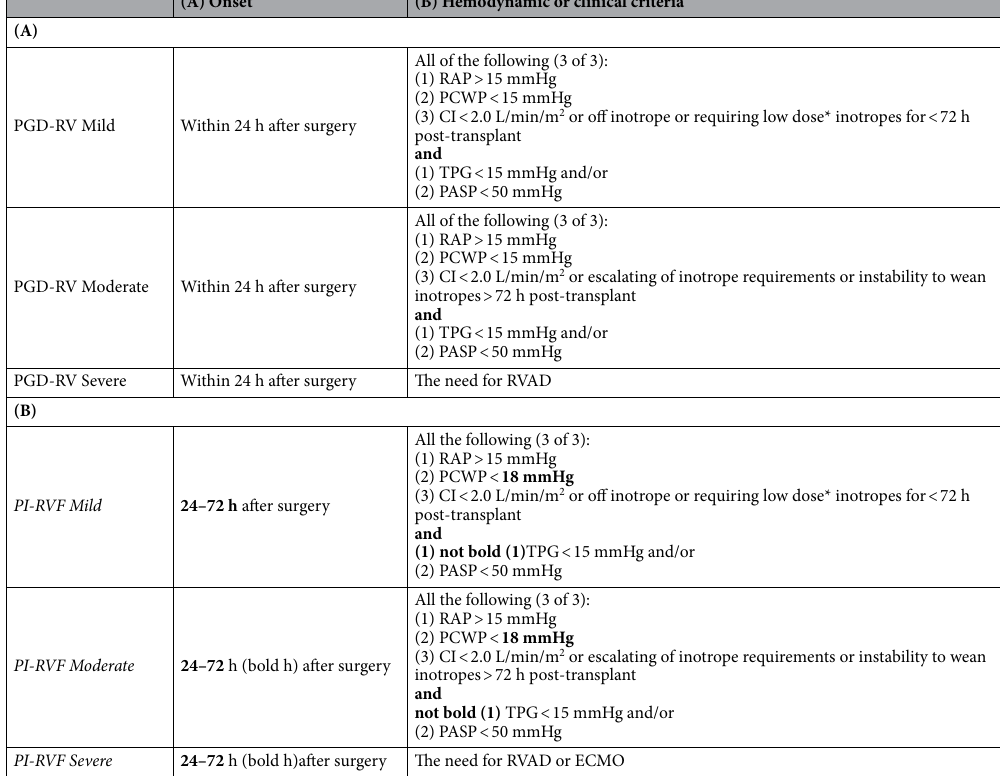
CNI initiation after 7 days post-transplant was commenced when the serum creatinine > 1.8–2 mg/dl. Post- transplant hemodynamic assessment was performed using a pulmonary artery (PA) catheter and an arterial line placed in the operating room prior to the transplant surgery in all patients. A chest radiograph combined with a good quality pressure waveform of pulmonary arterial pressure and PCWP was used to verify the position of the PA catheter tip in the intensive care unit (ICU). According to hemodynamic measurement protocols for the operating room and ICU, pressure transducers were calibrated to the zero level at the midaxillary line in the supine position before taking measurements. Mean right atrial pressure, pulmonary arterial pressure, and arte- rial pressure were measured and recorded every hour or more frequently if clinically indicated. PCWPs, cardiac output, CI, and systemic vascular resistance (SVR) were measured and recorded every 4 h post-operation or more frequently if clinically indicated. After 96 h post-transplant, the frequencies of those invasive hemody- namic measurements were judged on a case-by-case basis by the attending physicians. Epinephrine, milrinone, and dobutamine were the most frequently used inotropes during post-operative period. Nitric oxide or inhaled iloprost was given for RV failure in selected cases. The maintenance immunosuppressive agents followed the standard protocol. Cyclosporine was administered orally 2–5 mg/kg/d to achieve blood trough levels of 250–275 ng/mL during week 4, 200–250 ng/mL during week 4 to month 6, and 150–200 ng/mL during month 6–12. In February 2014, tacrolimus was administered orally 0.05–0.1 mg/kg/d in place of cyclosporine to achieve blood trough levels of 10–14 ng/mL during week 4, 10–12 ng/mL during week 4 to month 6, and 10 ng/mL during month 6–12. MPS was administered orally 48 h post-transplant to maintain the dose of 1–1.5 g twice a day. Oral prednisolone was initiated at 1 mg/kg/d and then tapered to 0.5 mg/kg/d by day 7, 0.35 mg/ kg/d by week 3, and 0.1 mg/kg/d until stopping after month 6. Prophylaxis for infection included trimethoprim-sulfamethoxazole and fluconazole. A pre-emptive strategy for cytomegalovirus (CMV) treatment was applied to all patients. Endomyocardial biopsies were obtained at numerous times post-transplant (Weeks 1, 2, 3, 4, 6, 8, 12, 14, 16, 20, 24, 32, 40, and 48 and every year for 5 years).